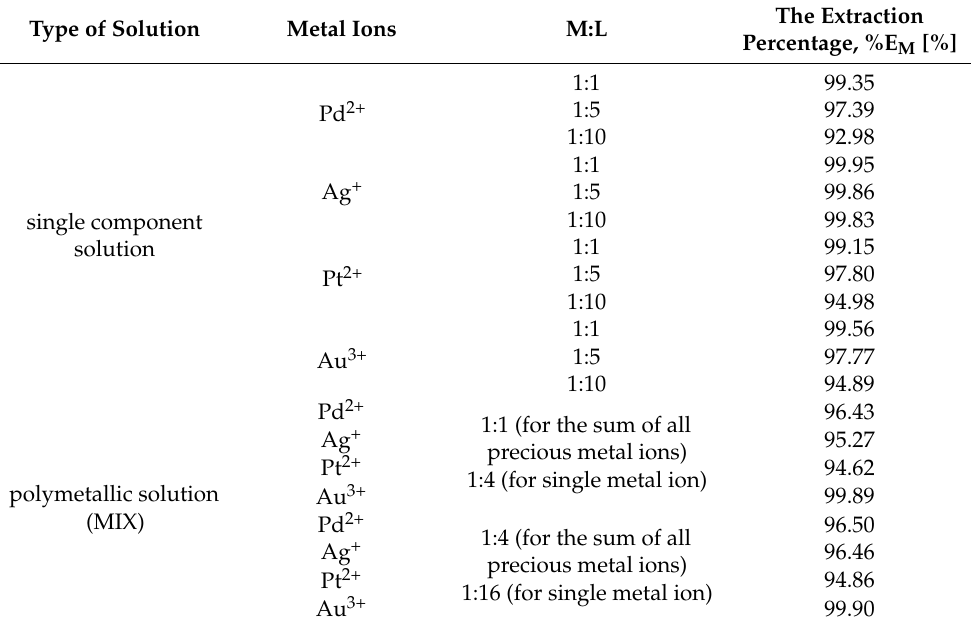
Table 3. The results of extraction percentages in various molar ratios M (Pd 2+ , Ag + , Pt 2+ , or Au 3+ ):L ( N,N' -bis(salicylidene)ethylenediamine) for single-component and polymetallic solutions. Type of